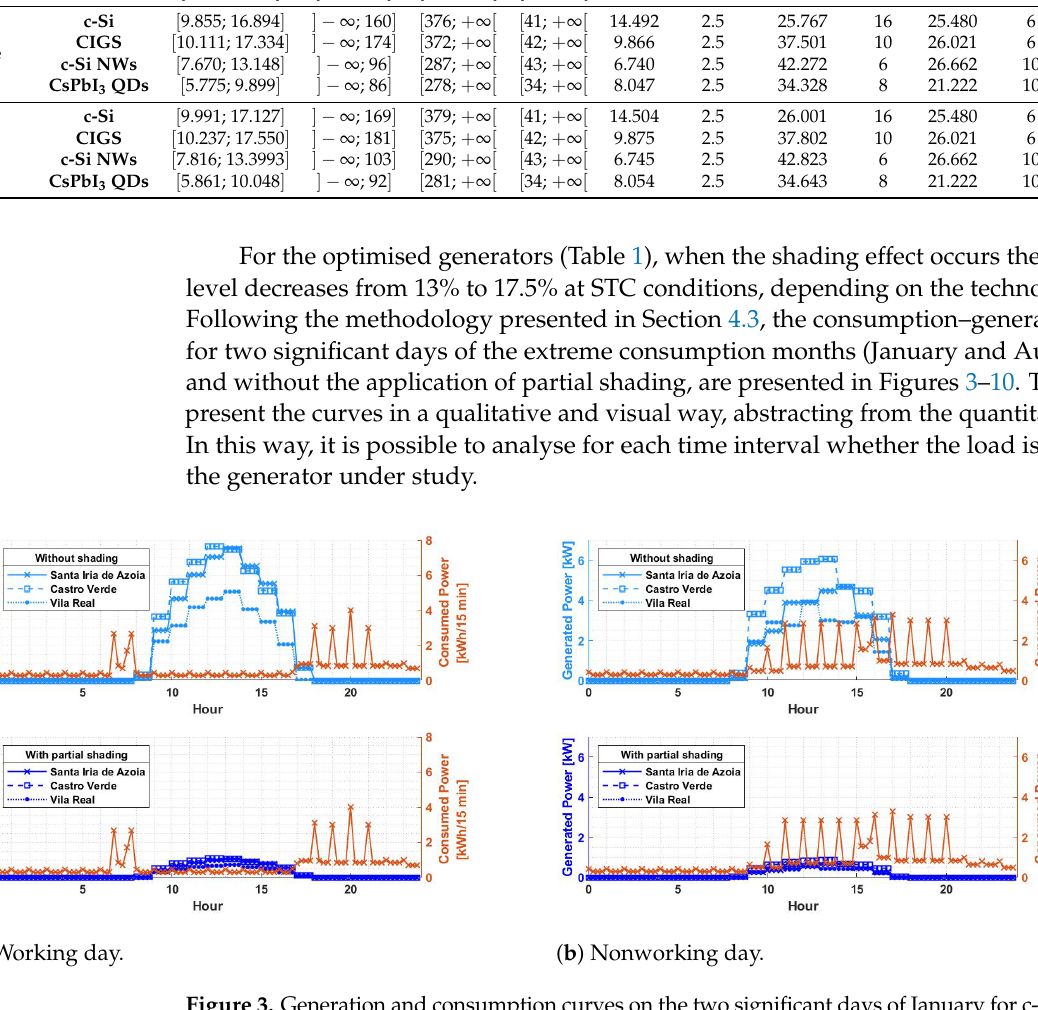
Figure 3. Generation and consumption curves on the two significant days of January for c-Si